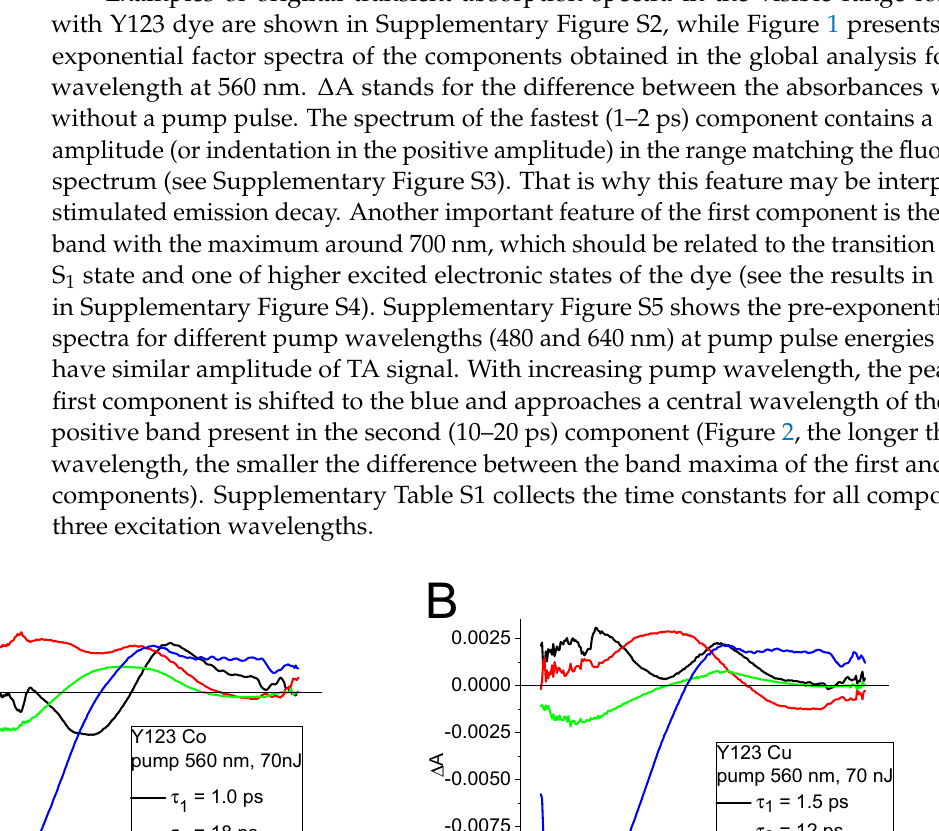
Figure 2. Maxima of the positive band in pre-exponential factor spectra of the ( A ) first and (B ) second component of the global analysis for Y123 solar cells. The wavelength-dependent amplitude of the second component contains also a neg- ative signal or an indentation in the positive signal in the range between 700 nm and 850 nm, which can be assigned to the stimulated emission and/or to building up of the oxi- dized state population (the rise of its transient absorption can be visible as the second peak in the photoinduced absorption measurements [46]). For the samples containing a cobalt redox mediator, the positive band in the short wavelength part of the spectra, may be distorted by the residuum of the stimulated emission from hot (Franck–Condon) S 1 state of the dye. Small shifts (~10 nm) between the spectra recorded in Co and Cu based elec- trolytes, observed, e.g., in the positions of bleach bands in Figure 1, the positions of the absorption maxima in Figure 2, and IPCE spectra in Supplementary Figure S1B should be